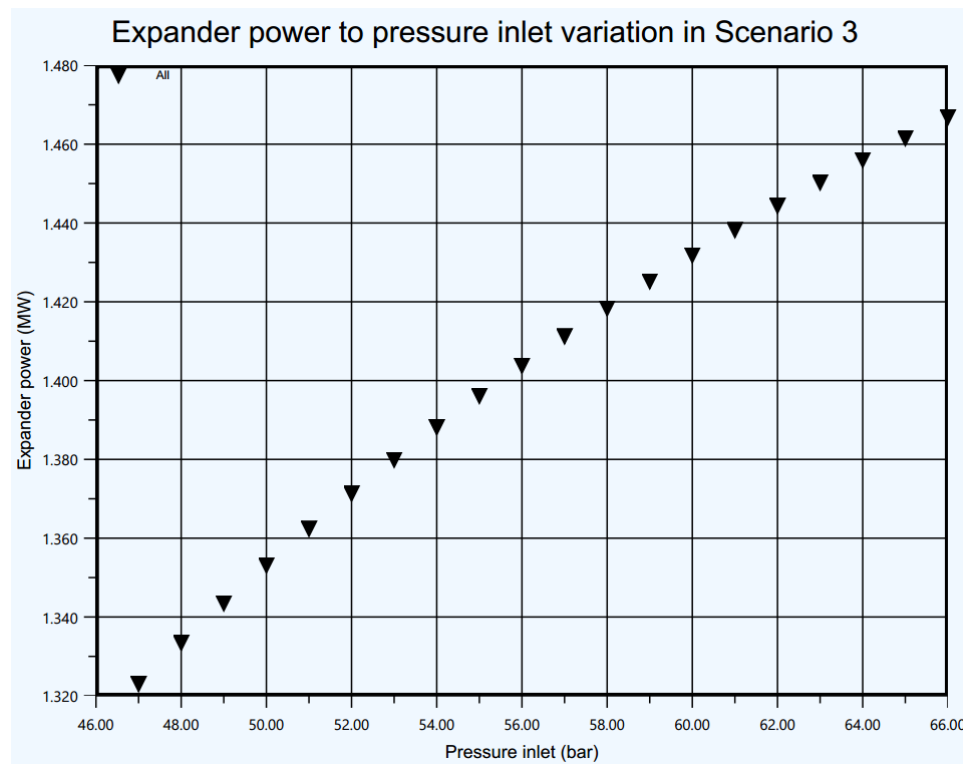
Figure 11. Expander power to gas feed pressure curve in scenario 3.